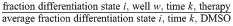
Differentiation-state time series portion of the test data.The sample mean and the sample standard deviation of fold change for each differentiation state are shown at each time point, computed from 4 samples. Fold change is fractiondifferentiationstatei,wellw,timek,therapyaveragefractiondifferentiationstatei,timek,DMSO, where fraction differentiation state i is the number of cells counted in that state divided by the population total.